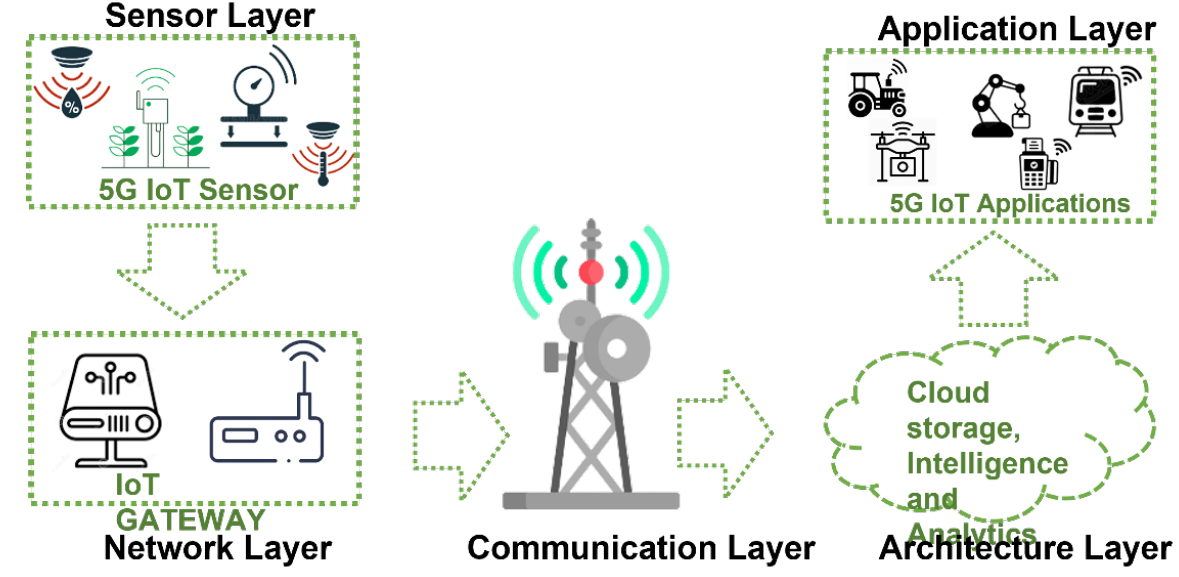
Figure 4. General 5G/IoT architecture. Source: [36].